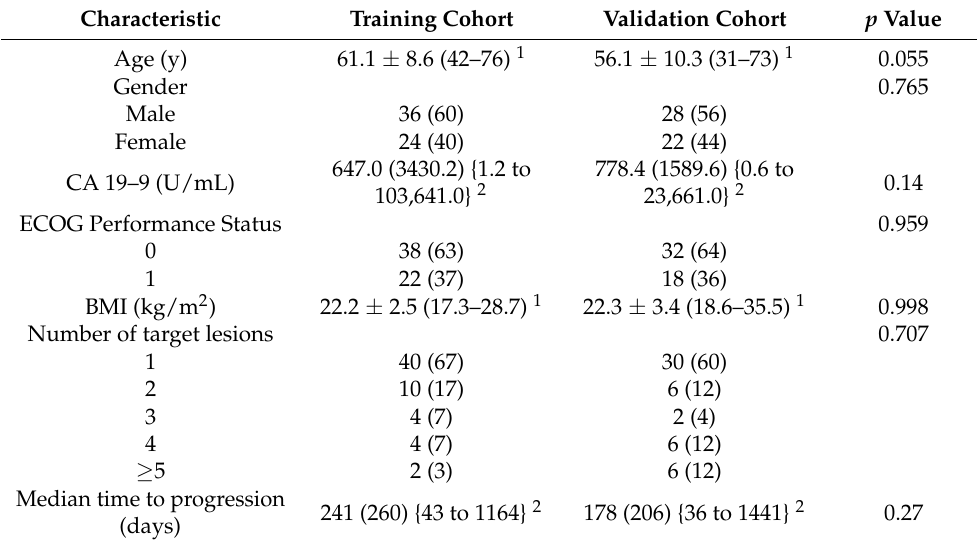
Table 1. Main baseline demographics and clinical characteristics of patients in the